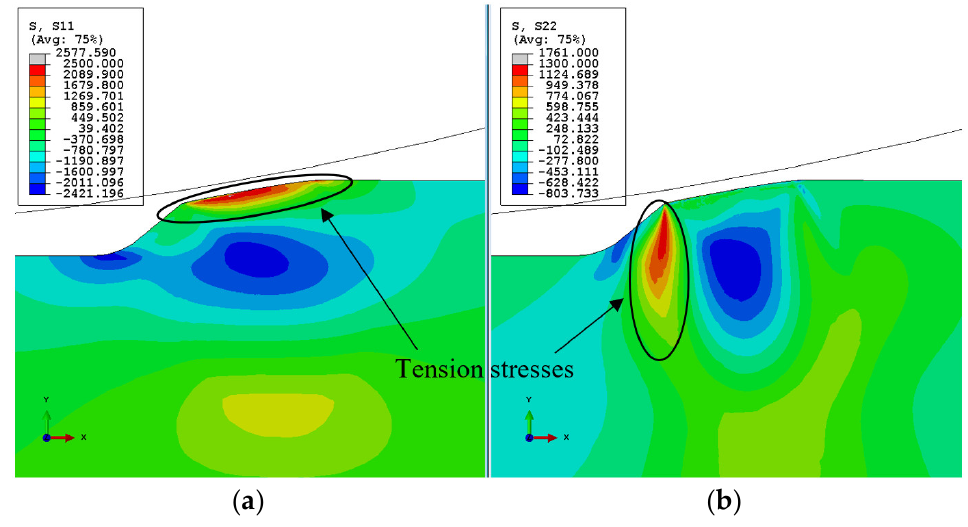
Figure 6. Simulated residual stresses ( a ) in the horizontal direction x, and ( b ) in the vertical direction y, in the unloading stage.